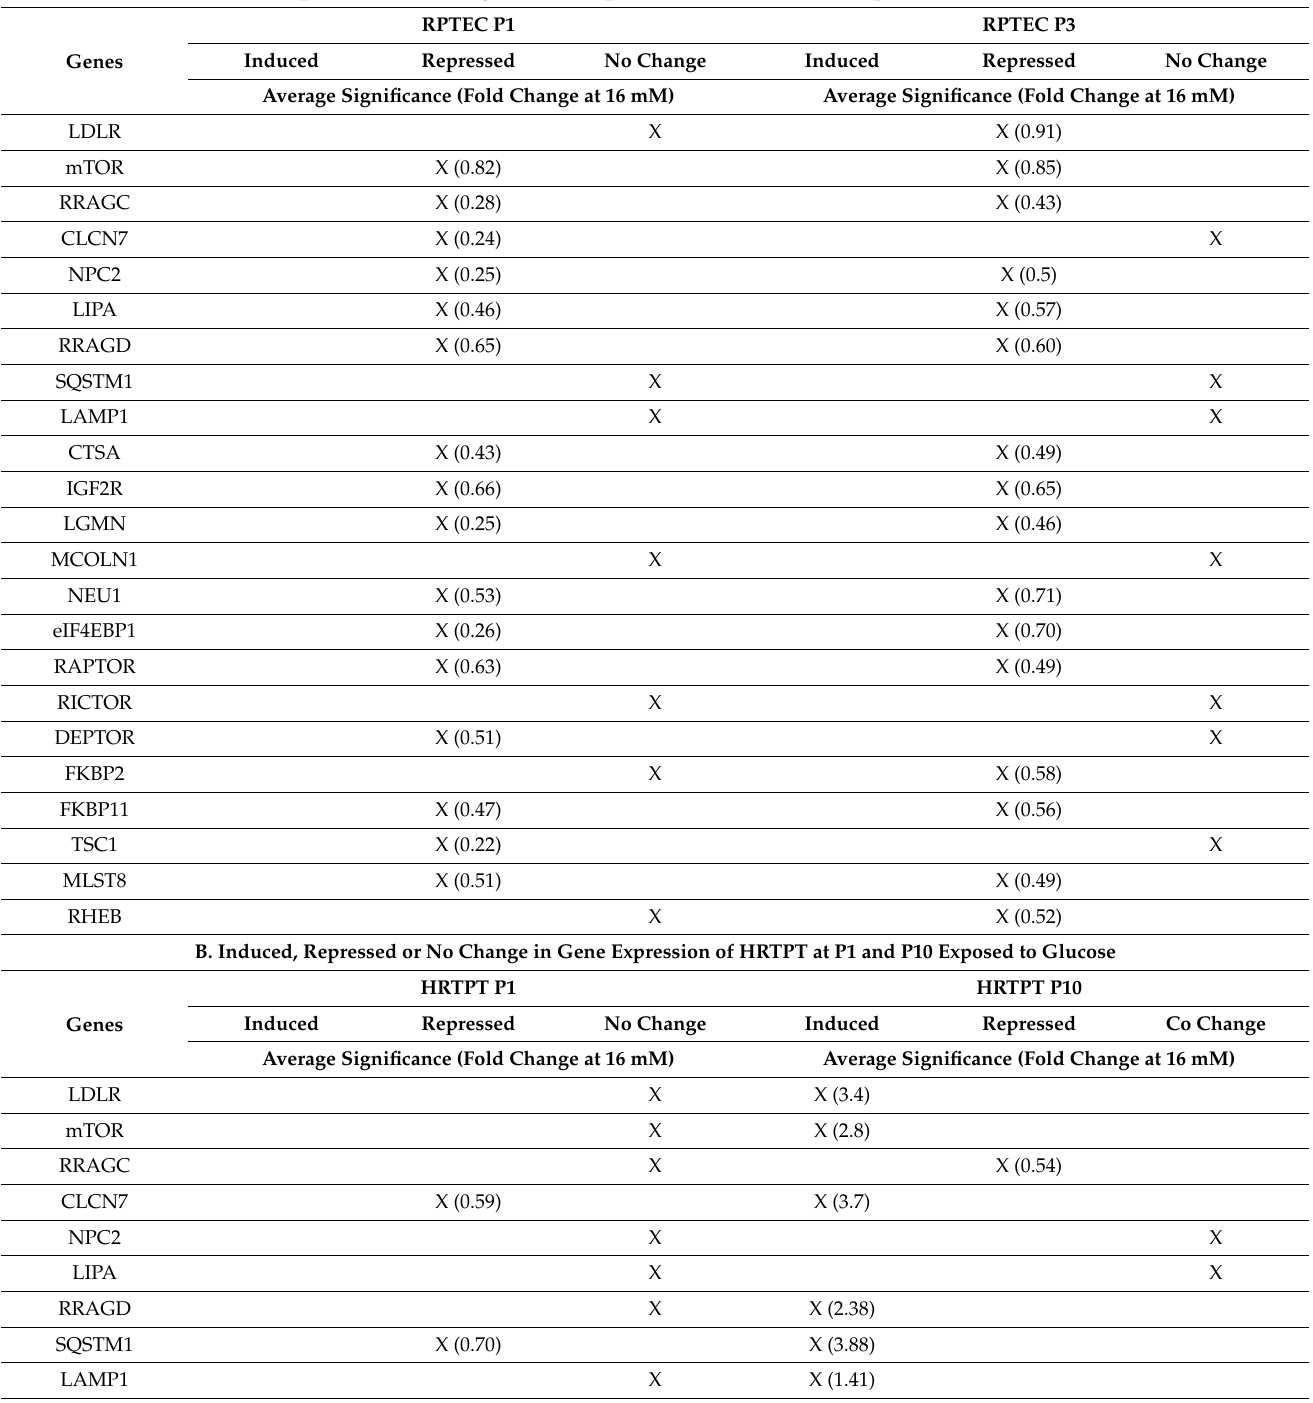
Table 1. A. Induced, Repressed or No Change in Gene Expression of RPTEC/TERT1 Exposed to Glucose at P1 and P3. B. Induced, Repressed or No Change in Gene Expression of HRTPT at P1 and P10 Exposed to Glucose. C. Induced, Repressed or No Change in Gene Expression of HREC24T at P1 and P7 Exposed to